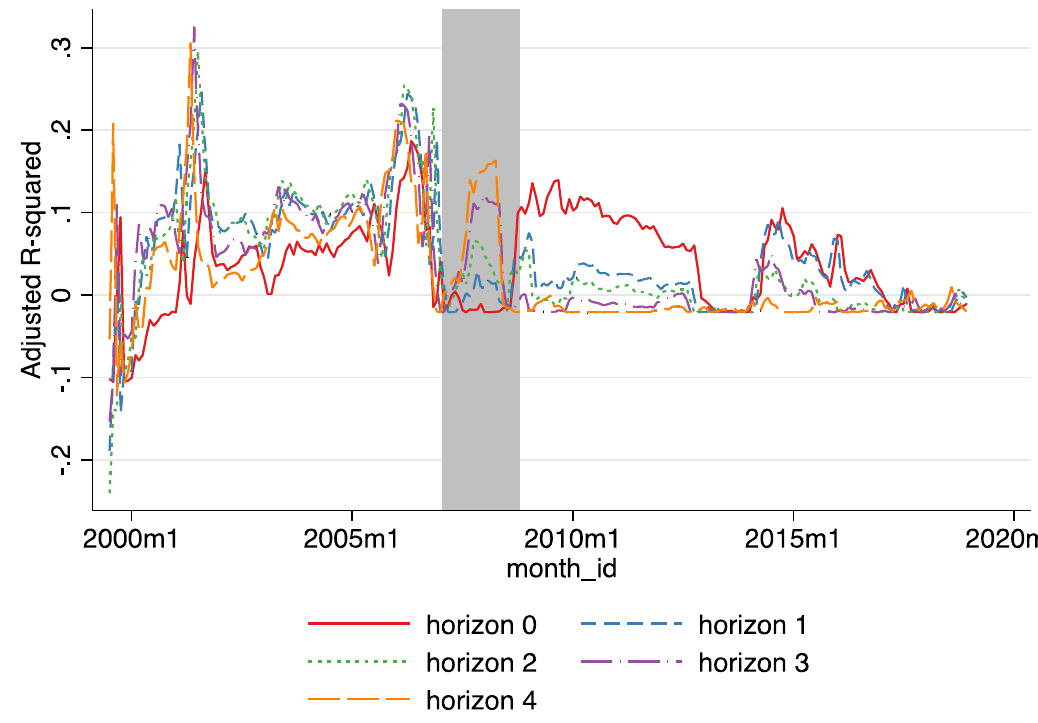
Note: The shaded area is the subprime crisis period. Figure 3. The adjusted R2 for a 50-month rolling window returns forecast from 1999–2018, for horizons 0 to 4 with Newest t